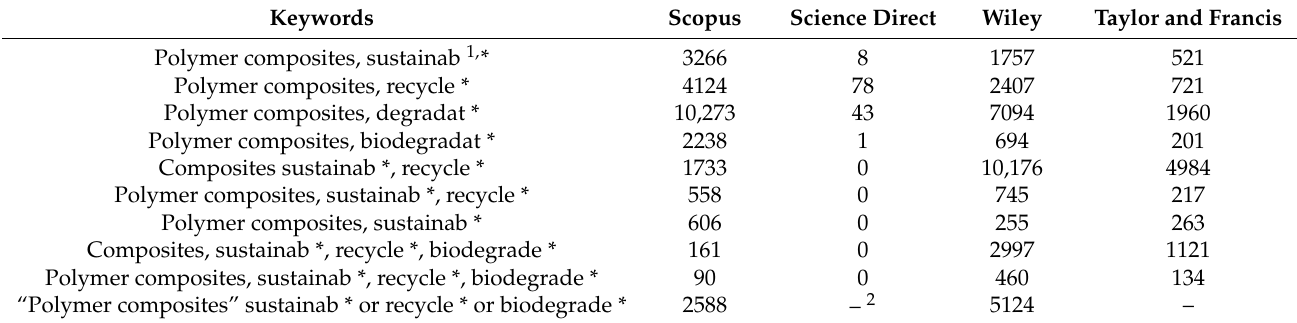
Table 1. Keywords used in the bibliographic search and number of documents recovered from several